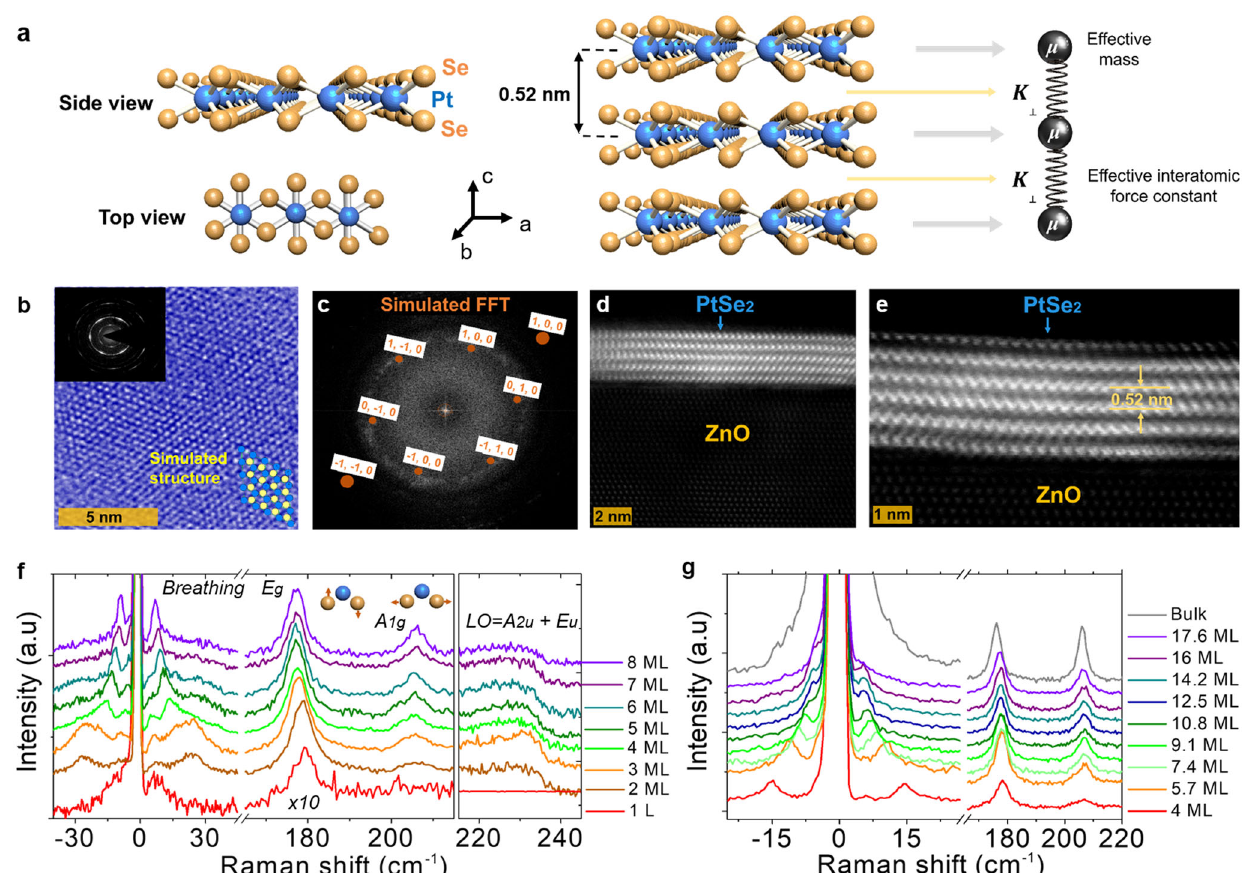
Fig. 1 Structural characterization and low-frequency Raman spectroscopy of PtSe 2 . a Side and top views of the PtSe 2 crystal structure (left), schematics of the side view of a trilayer PtSe 2 crystal structure (middle), and the one-dimensional linear atomic chain model (right). The blue and orange spheres represent Pt and Se atoms, respectively. b HR-STEM images of a 5 ML crystalline PtSe 2 fi lm and c the Fast Fourier transform of the respective image, from which we extract the a and b lattice constants, a = b ≈ 0.37 nm. d , e Cross-sectional TEM images of the as-grown 3 nm (5 ML) PtSe 2 fi lm, from which we extract the c -lattice constant, c ≈ 0.52 nm. The PtSe 2 is layered and each layer is parallel to the underlying ZnO substrate. Thickness-dependent Raman spectra of f crystalline and g polycrystalline PtSe 2 fi lms deposited on ZnO. The inset in ( f ) shows blue and orange spheres that represent Pt and Se atoms, respectively and arrows that point to the direction of the movement of that